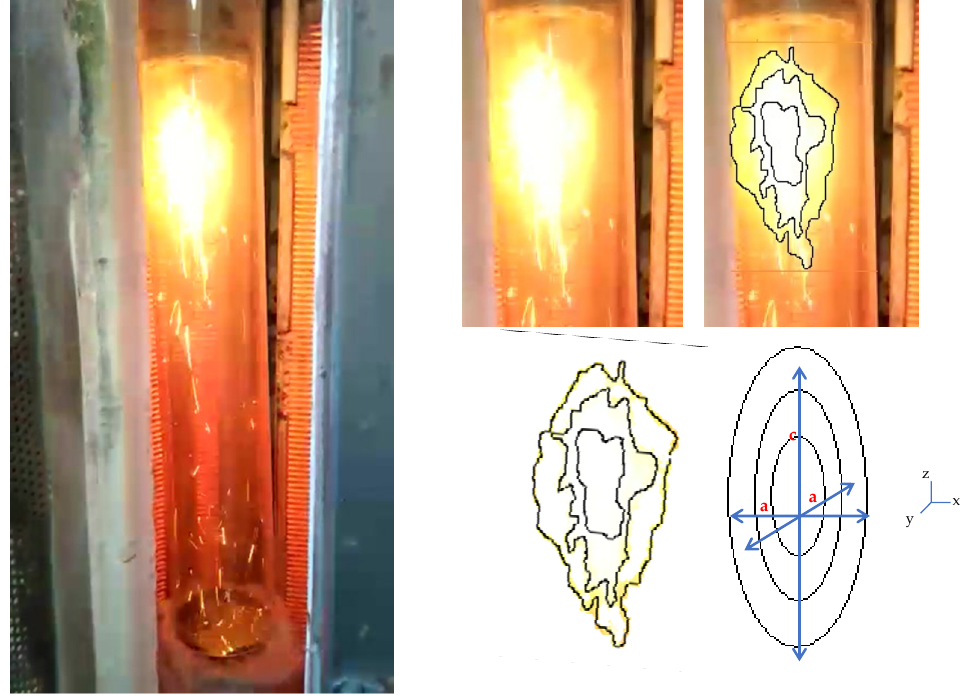
Figure 5. Estimation of the flame volume; a = 3.4 cm and c = 5.86 cm and A = 174 cm 2 [24].